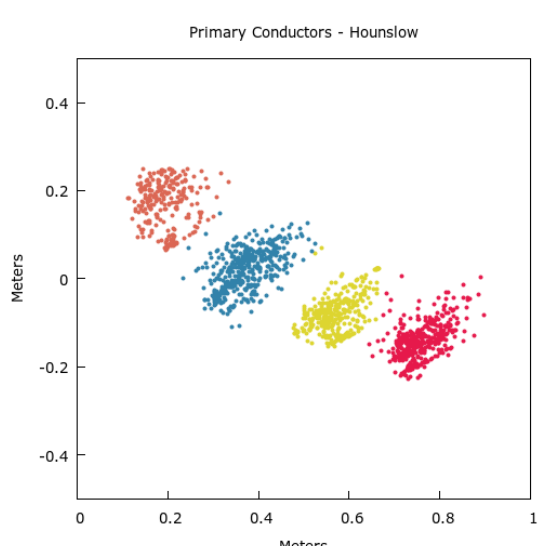
Figure 9. Example of 2-Dimensional Mean Shift clustering of primary conductors from the Hounslow dataset. Note there is some cross span-wise overlap which results in less defined boundaries if only the cross span-wise component is used.